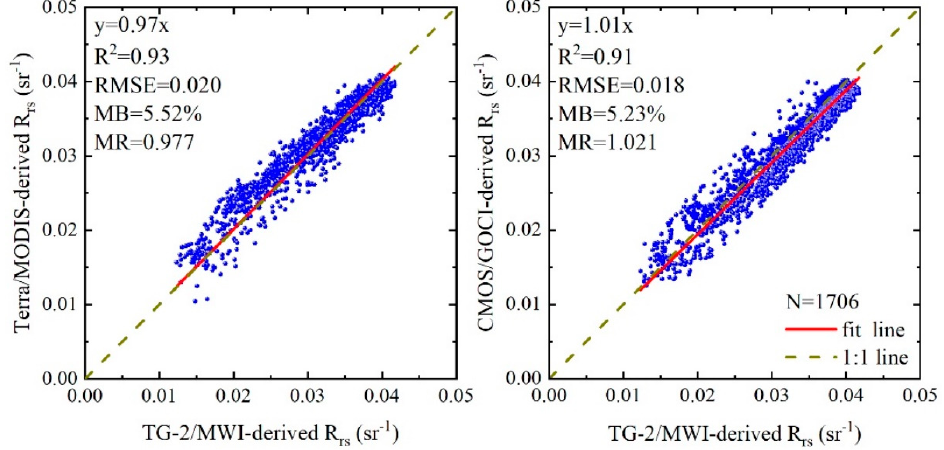
Figure 9. Statistical analysis of TG-2/MWI-derived Rrs, Terra/MODIS-derived Rrs and CMOS/GOCI-derived Rrs products.